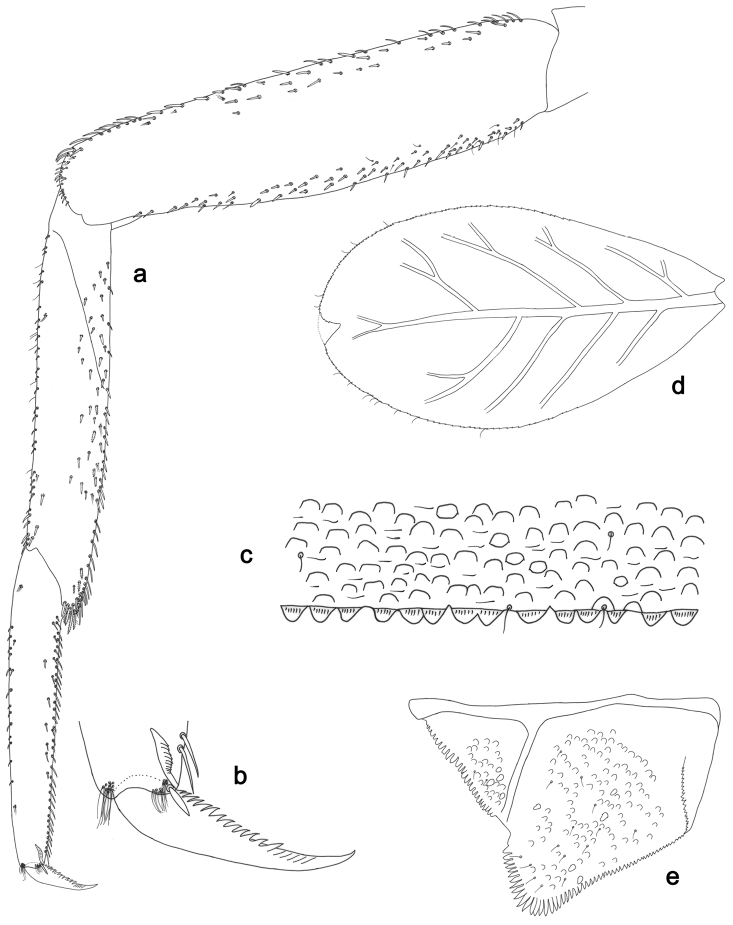
Labiobaetispindaundensis sp. n., larva morphology: aForelegb Fore claw cTergum IV d Gill IV eParaproct.